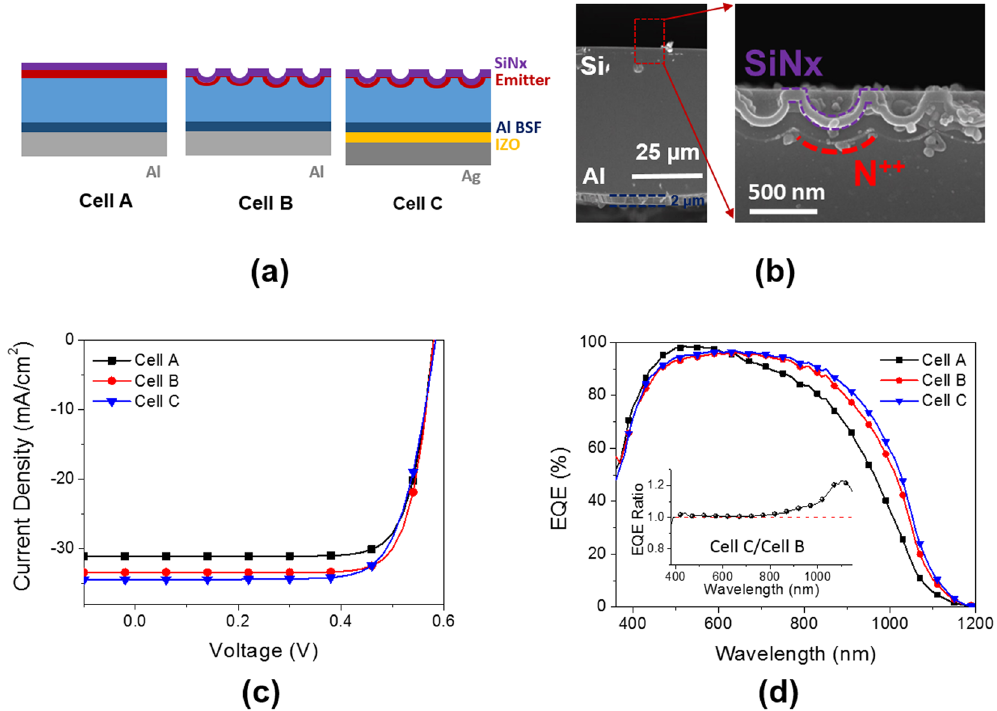
Figure 8. ( a ) Three different device architectures of solar cells based on kerfless wafers. ( b ) Cross-sectional images of the solar cells with the device architecture of cell B. The nanohole arrays on the front side is magnified. A heavily doped region (N ++ ) and a SiN x layer are distinctly shown by a selective etching. ( c ) Current-voltage characteristics of the solar cells of three different device architectures under a standard solar irradiation of AM 1.5 G. ( d ) EQE spectra of the solar cells with the different architectures. The inset figure present normalized EQE spectra of cell C to cell